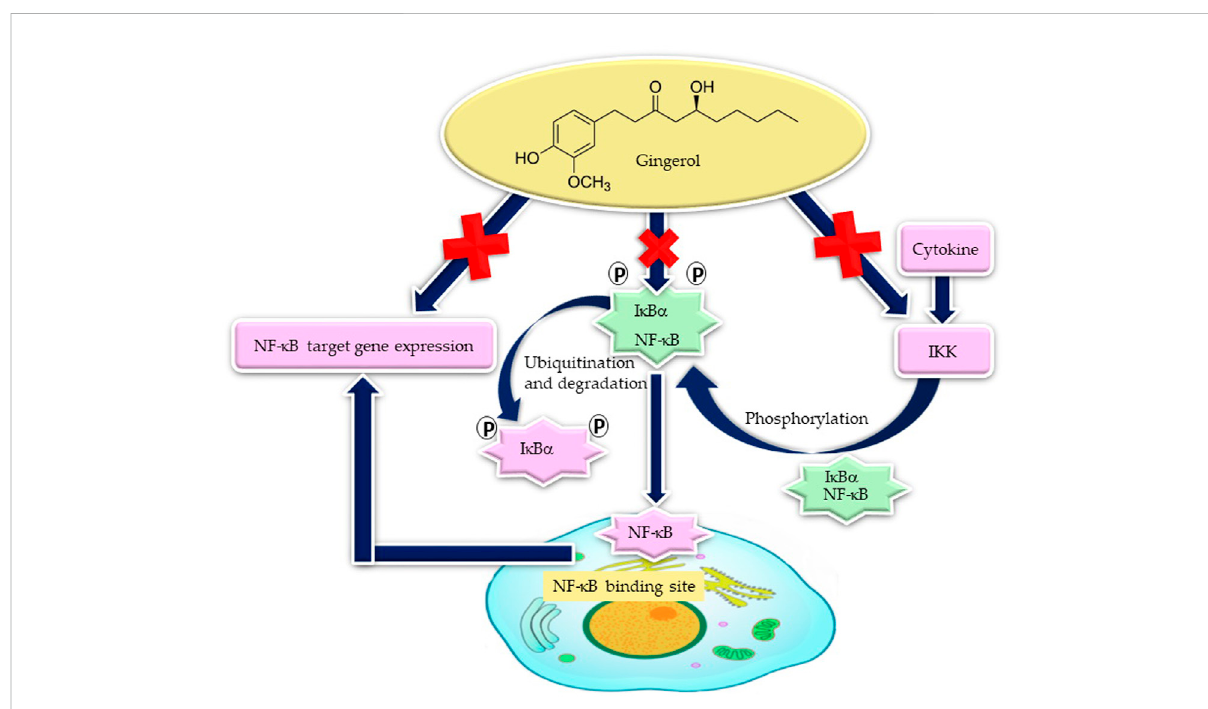
FIGURE 5 GingeroldecreasesNF- l Btargetin fl ammatorygeneexpressionbythesuppressionofNF- l Bactivity,throughthestabilizationofinhibitoryI l B α and degradation of I l B α kinase (IKK) activity [adapted from the work of Li et al.